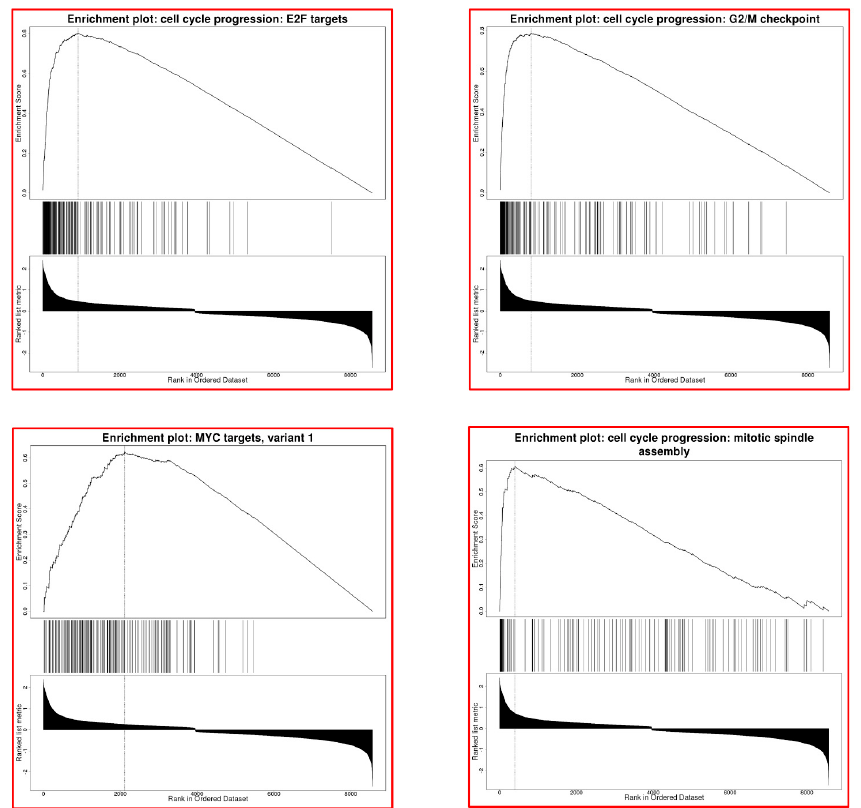
Figure 11. TCGA database analysis of the clinical significance and function of FAM64A in LUAD clinical specimens. The bar graph shows the results of gene set enrichment analysis (GSEA) of the genes differentially expressed between high and low FAM64A expression groups in LUAD patients. Four representative GSEA plots are shown below for E2F targets, G2/M checkpoint, MYC target 1 variant 1 and mitotic spindle assembly with q-values < 0.05. These pathway terms were significantly enriched in the high FAM64A expression group.